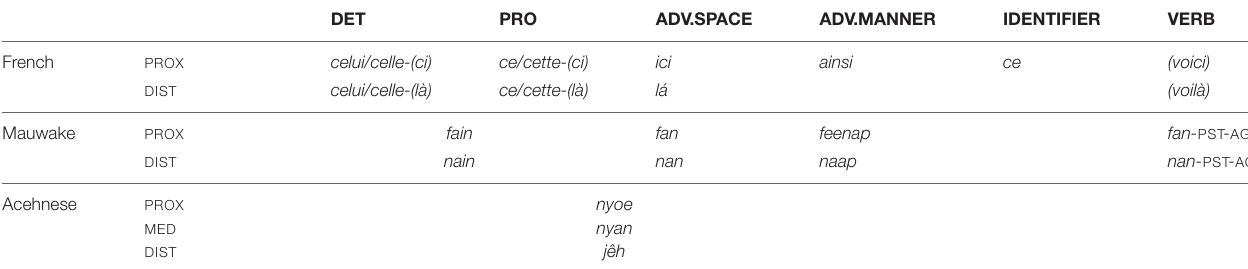
TABLE 1 | Examples of demonstrative word class systems. DET PRO